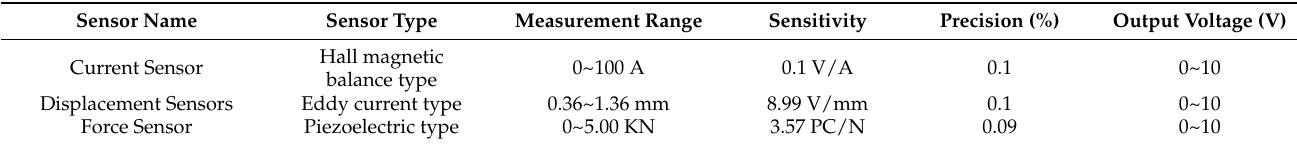
Figure 4. The static electromagnetic force test stand. Table 1. Sensor parameter.